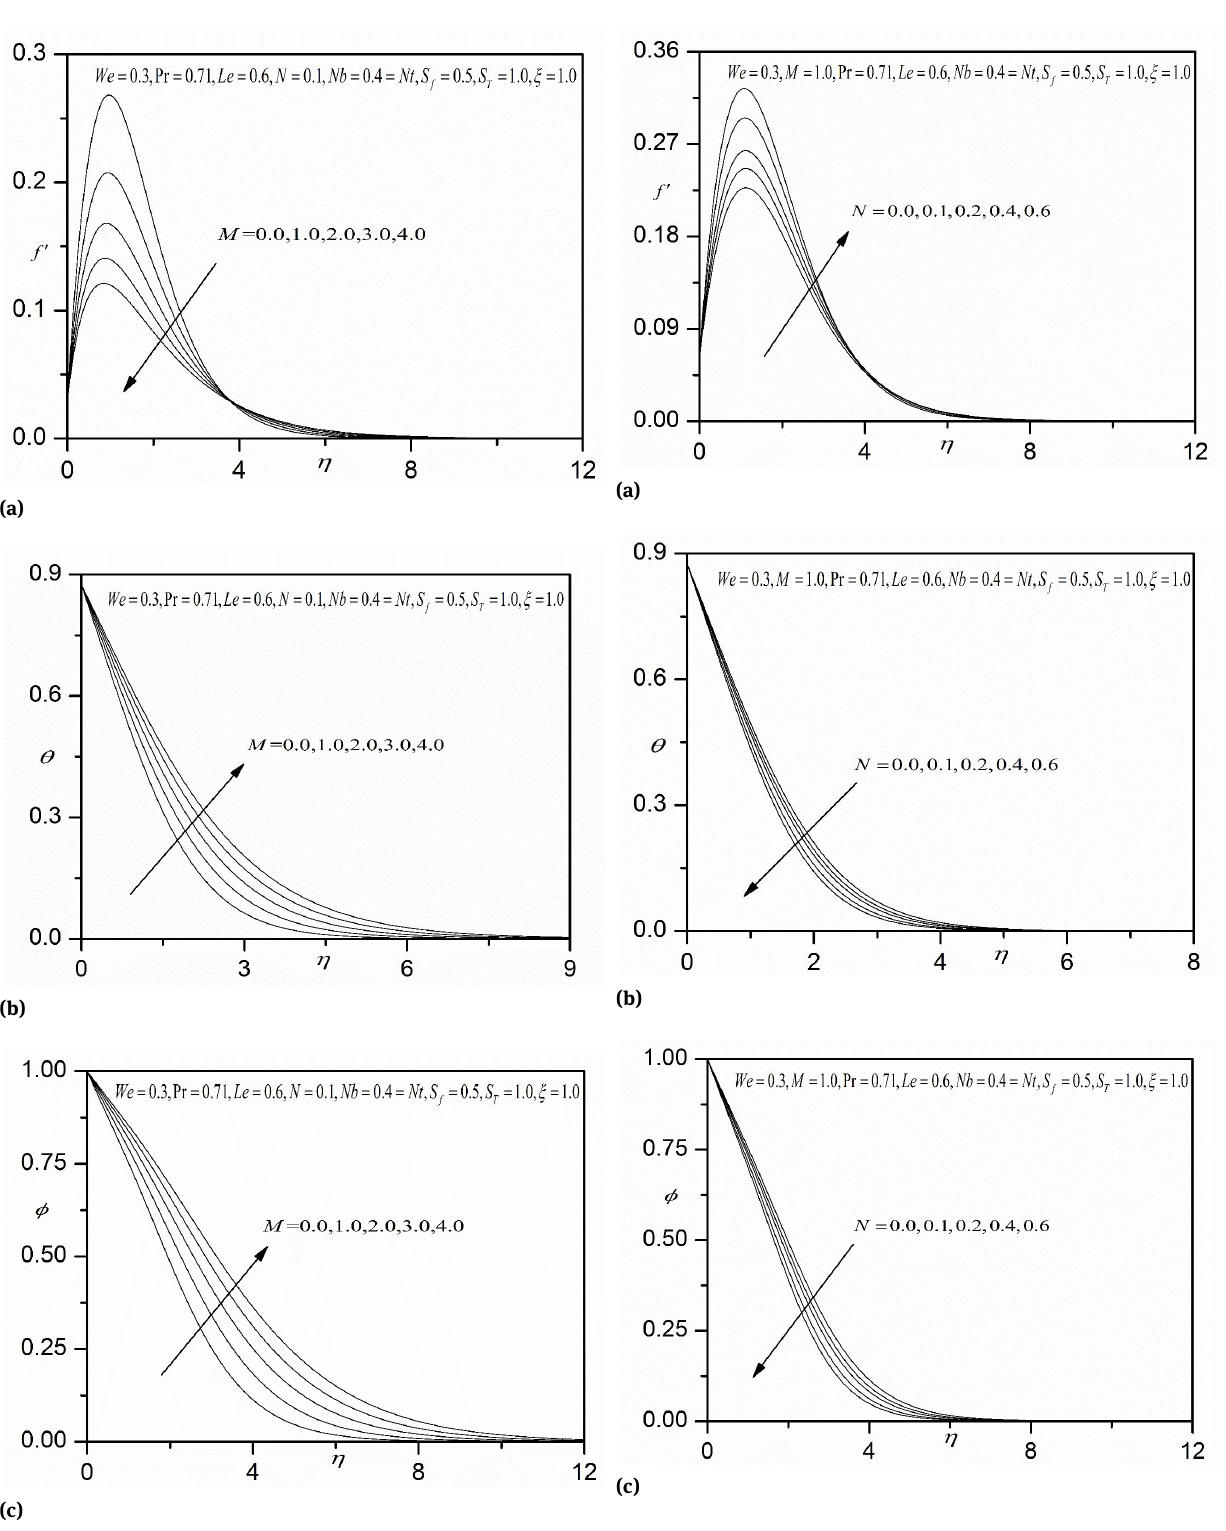
Fig. 5: (a) Effect of N on velocity profile; (b) Effect of N on tempera- ture profile; (c) Effect of N on concentration